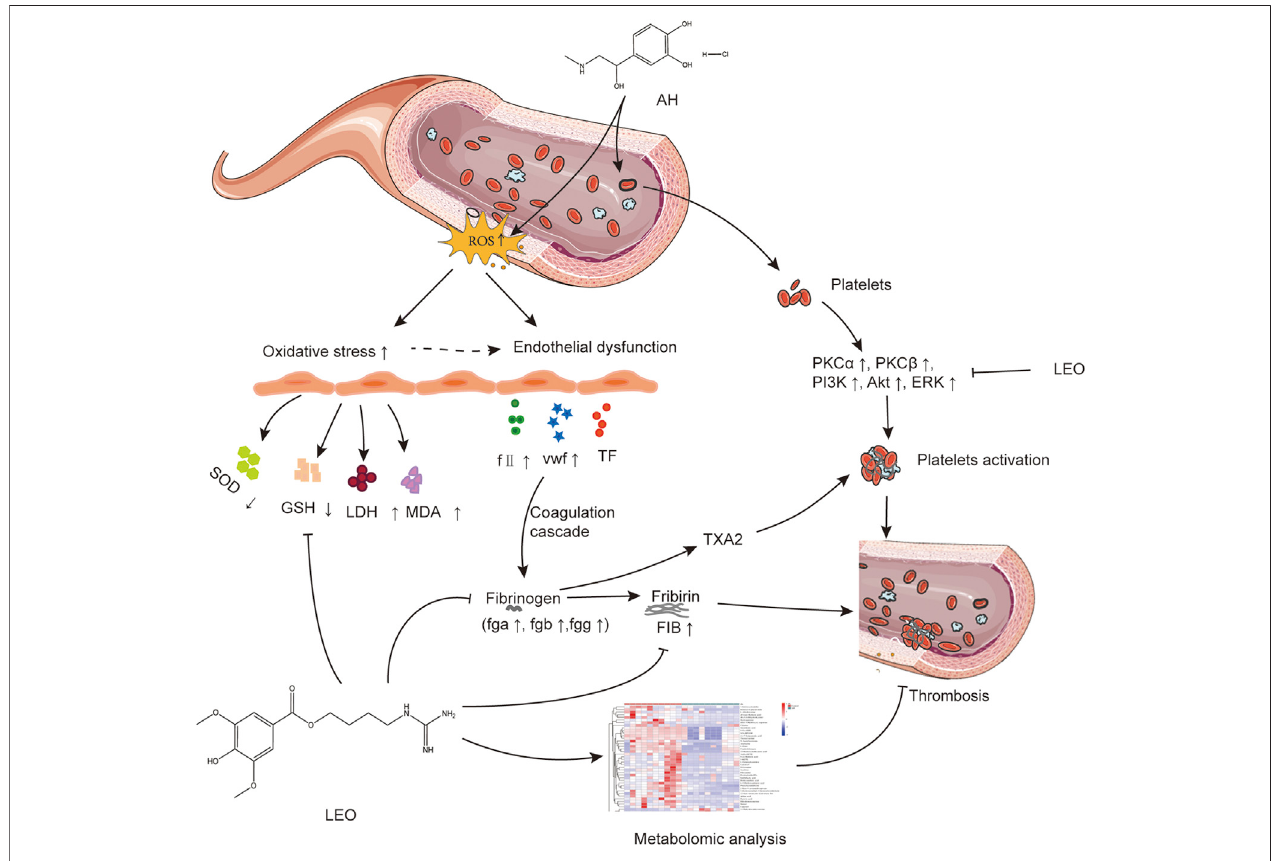
FIGURE 13 | The potential mechanism linking dysregulated oxidative stress, platelets activation, and coagulation cascade with thrombosis.